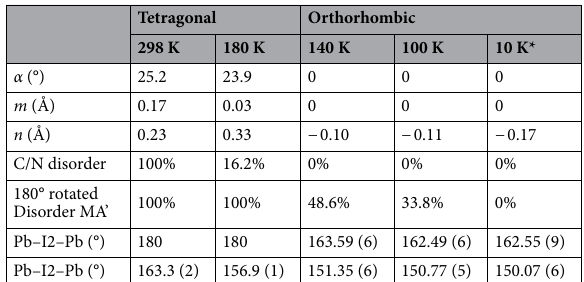
Table 1. Main characteristic parameters of MA behavior at different temperatures. *Values correspond to a deuterated sample reported by Whitfield et al . 41 .